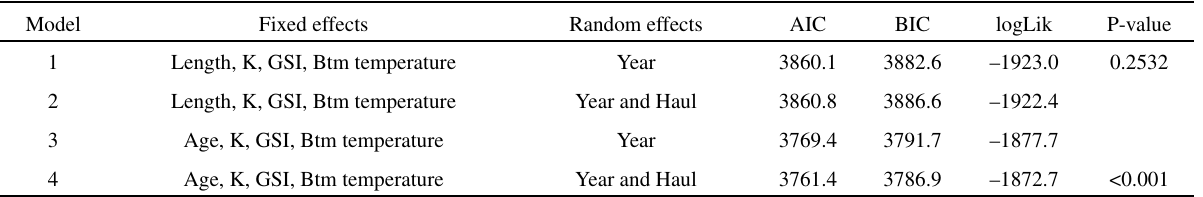
Table S1. – Selection of random effects for GLMM fitted with potential fecundity as a dependent variable. First, optimal random effects were tested. The covariates in all models (i.e. fixed structure) are the maternal traits length/age, , condition factor (K), gonadosomatic index (GSI)